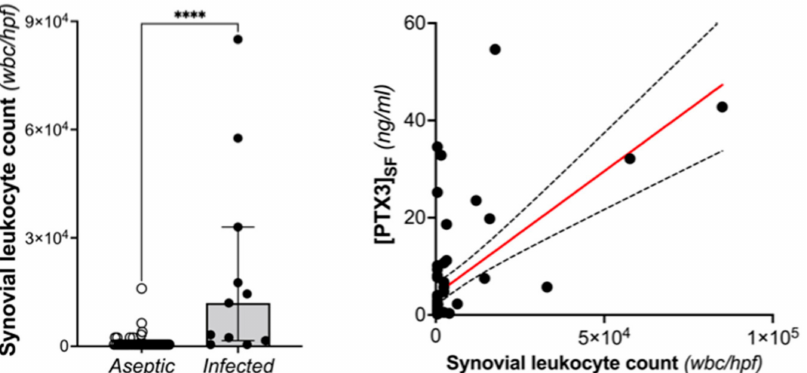
Figure 5. Leukocyte count in the synovial fluid of THA and TKA patients with and without PJI (based on MSIS criteria; Mann-Withney, **** p < 0.0001) and its correlation with the concentration of PTX3 (Spearman r: 0.498, p <